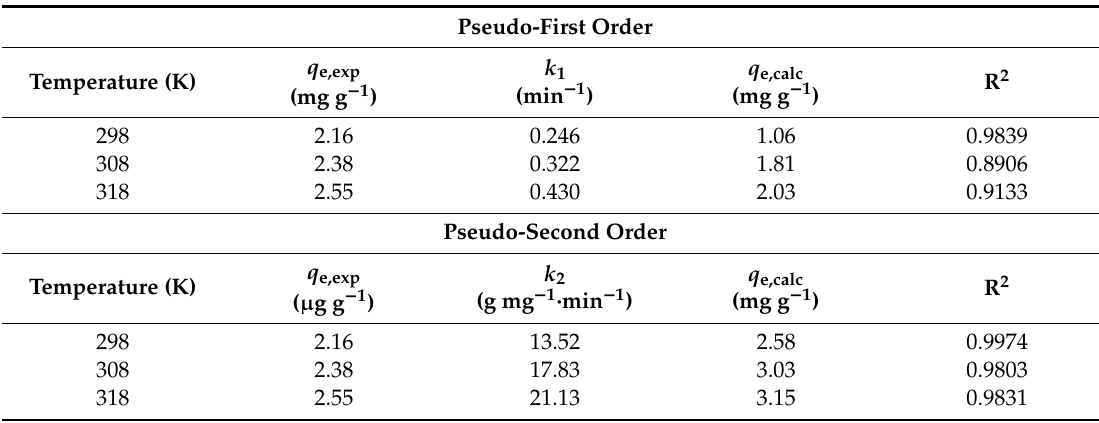
Table 1. Kinetic parameters for the adsorption of colloidal silver onto material / textile /